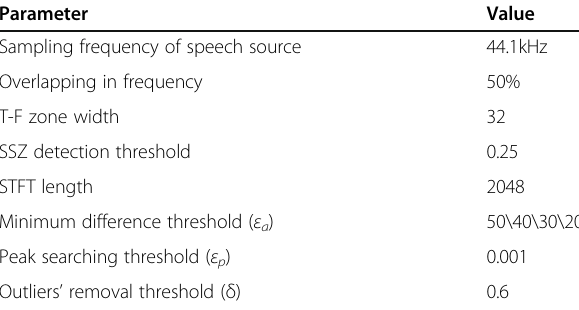
Table 1 Experimental